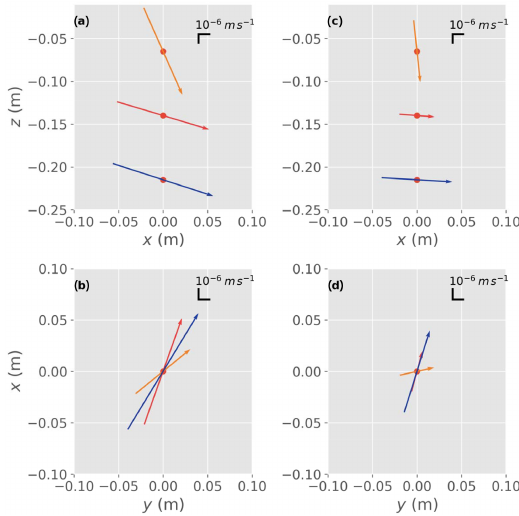
Figure 8. Calculated fluxes and flux directions at the three heat in- jection depths from two of the stations at the experimental field site. (a, b) Station 1 and (c, d) Station 2. The x axis in the figures is positive in the direction of